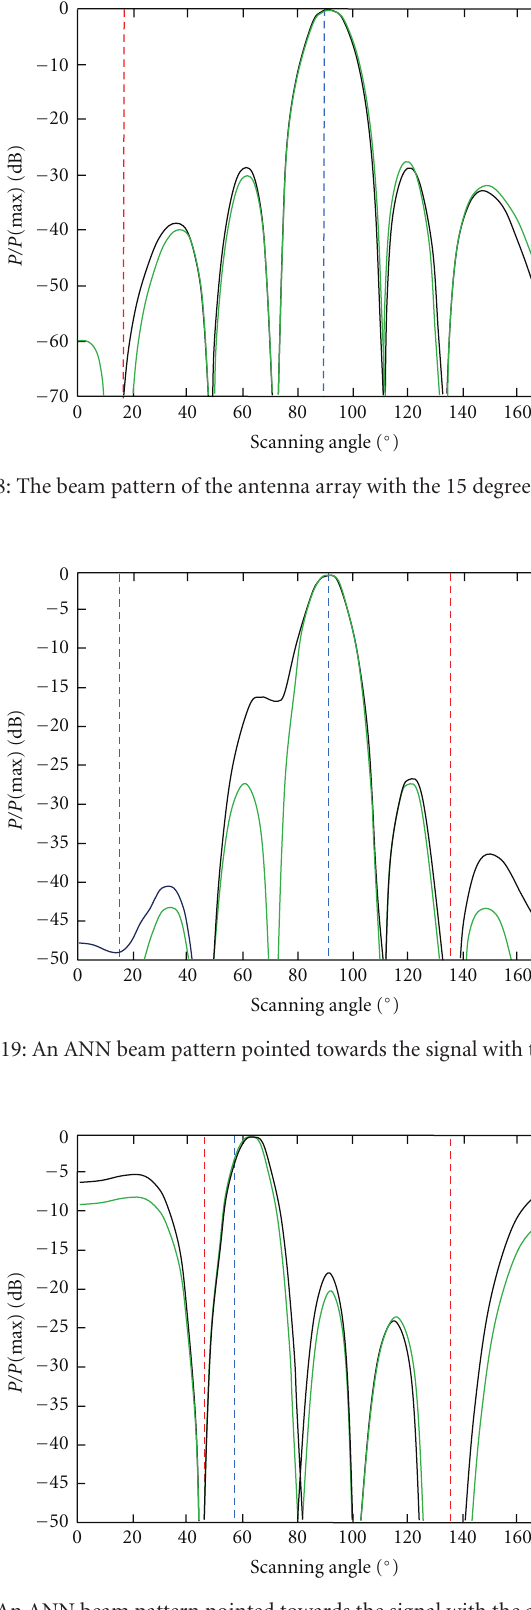
Figure 20: An ANN beam pattern pointed towards the signal with the angle of 55